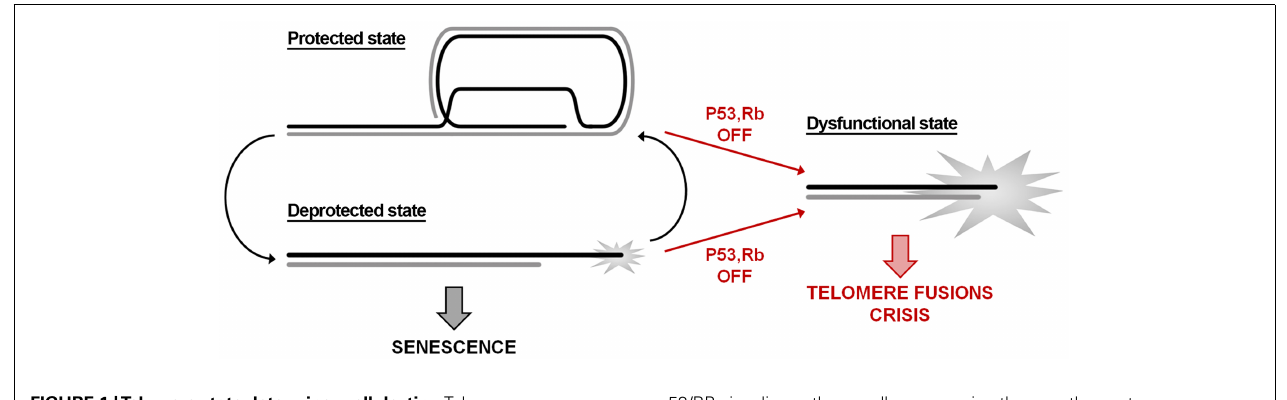
FIGURE 1 |Telomere state determines cell destiny. Telomeres swing between a protected and a deprotected state throughout the cell cycle. Accumulation of more than five deprotected telomeres is sufficient to induce replicative senescence.The inactivation of